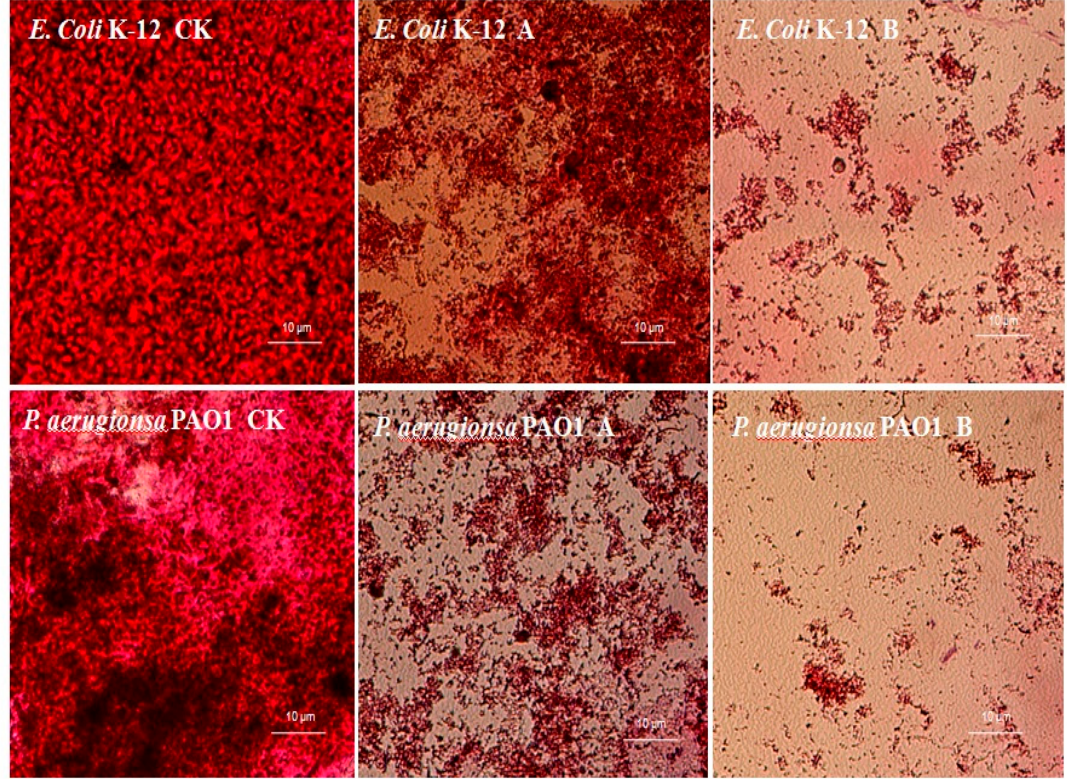
Figure 5. Scavenging effects of CFEE on mature biofilms formed by E. coli K-12 and P. aeruginosa PAO1. (A) 200 μ g/mL; (B) 400 μ g/mL.